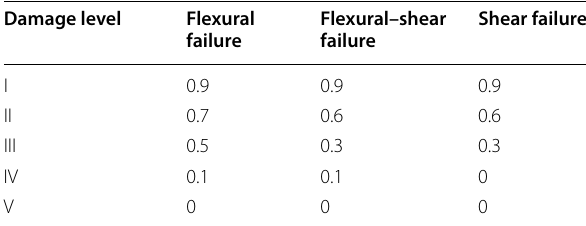
Table 4 Suggested reduction factors of seismic capacity for damaged RC